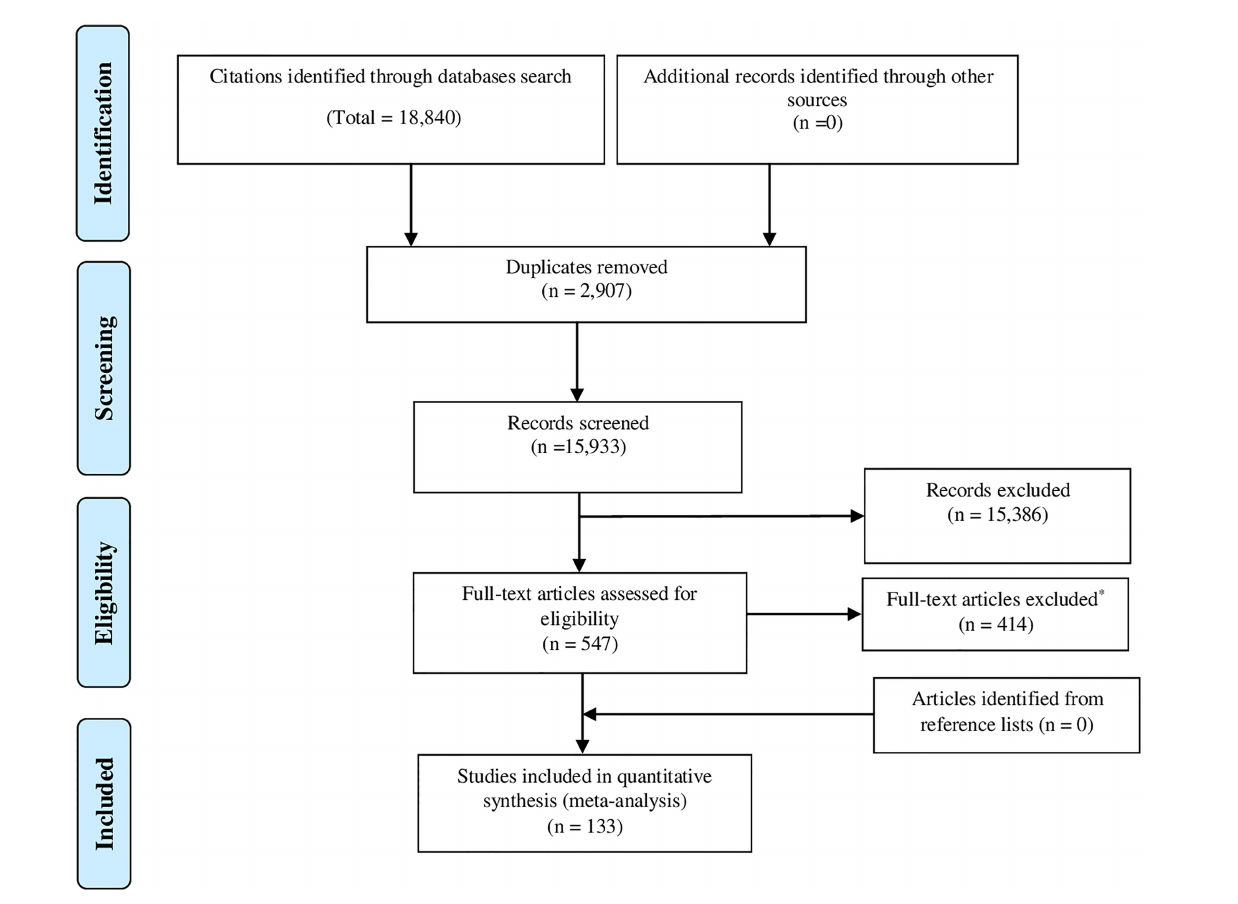
FIGURE 1 | PRISMA fl owchart. (cid:129) Reasons for full-text exclusion: 214 GDM or DM total population 78 Wrong setting 29 Not in Europe 24 GDM Prevalence was incalculable 23 reported an unclear ascertainment of GDM criteria (I report containing information front Albania, 3 from Denmark, 2 from Finland, 2 from Ireland, 5 front Italy, I from Netherlands, 2 f:om Poland, 2 from Portugal, 2 from Spain, and 3 from United Kingdom). 15 reports have duplicate data [I from Croatia (30), I from France (31), I from Italy (32), 2 from Netherlands (33,34),6 from Norway (35-40), and 4 from United Kingdom (41-44)], and only the report that fi rst published the study data was used. 9 Conference abstract with not enough information 8 Case-control (GDM vs . non-GDM) 7 Duplicates 6 Wrong patient population 1 Year of GDM diagnosis is UNCLEAR (Not mentioned).